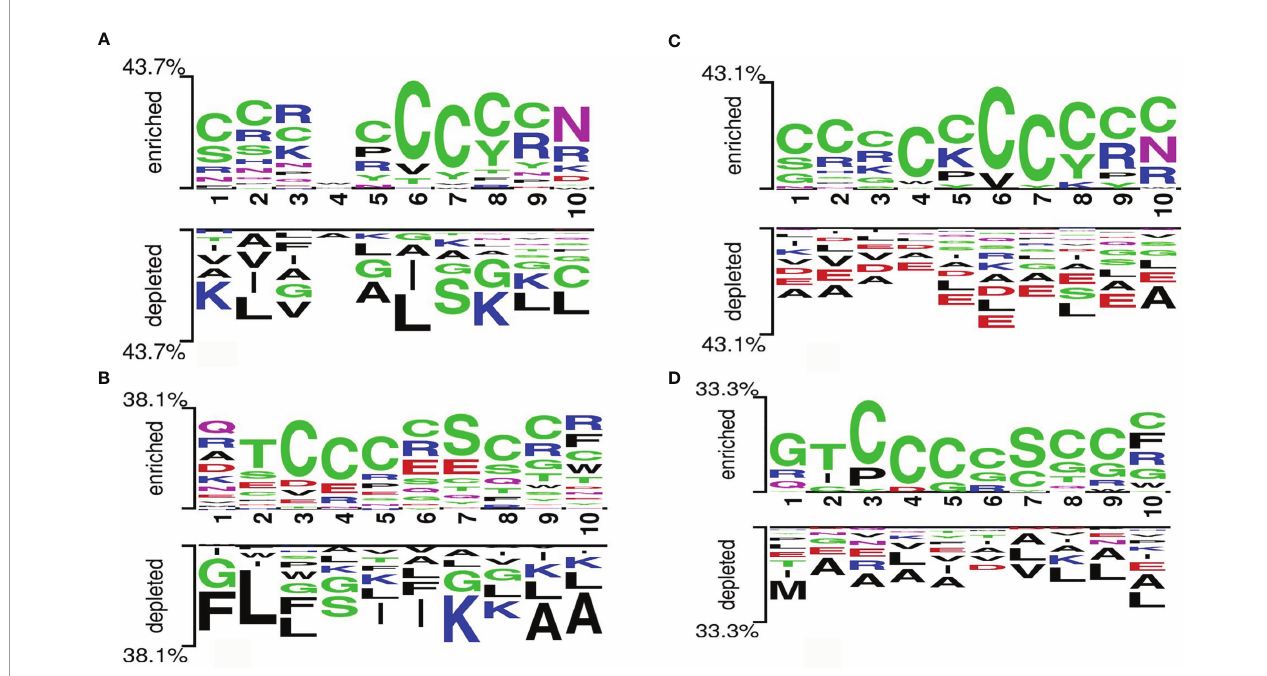
FIGURE 4 | Two-sample logos generated from the (A) C-terminus (last 10 residues) of the main dataset, (B) N-terminus ( fi rst 10 residues) of the main dataset, (C) C-terminus (last 10 residues) of the alternate dataset, and (D) N-terminus ( fi rst 10 residues) of the alternate